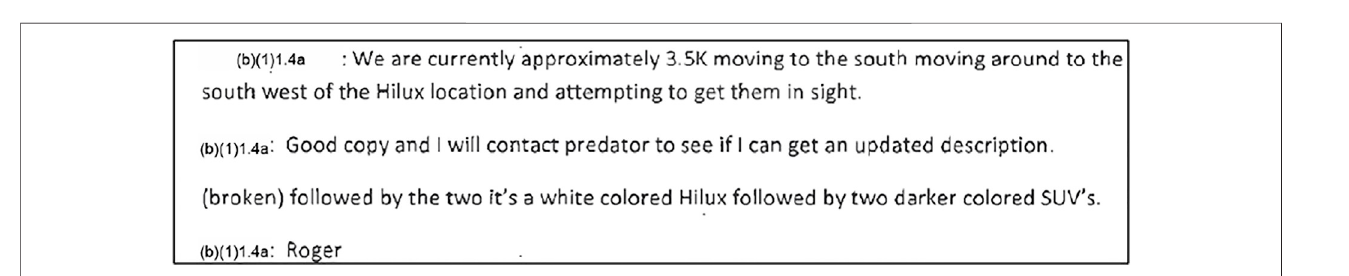
FIGURE 2 | Excerpt from the Kiowa